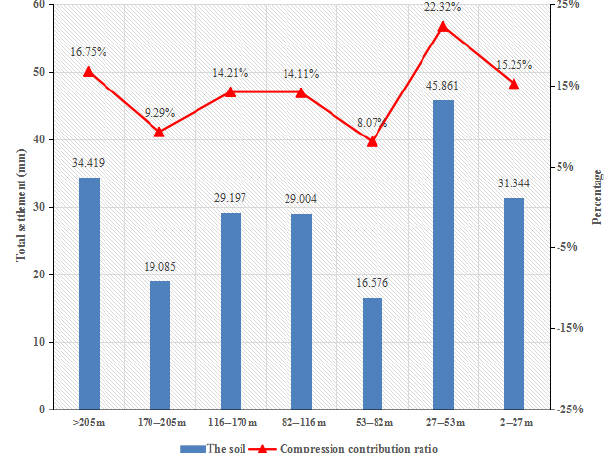
Figure 8. Deformation behaviour of the shallow soil mass in rela- tion to its corresponding groundwater level at layered mark